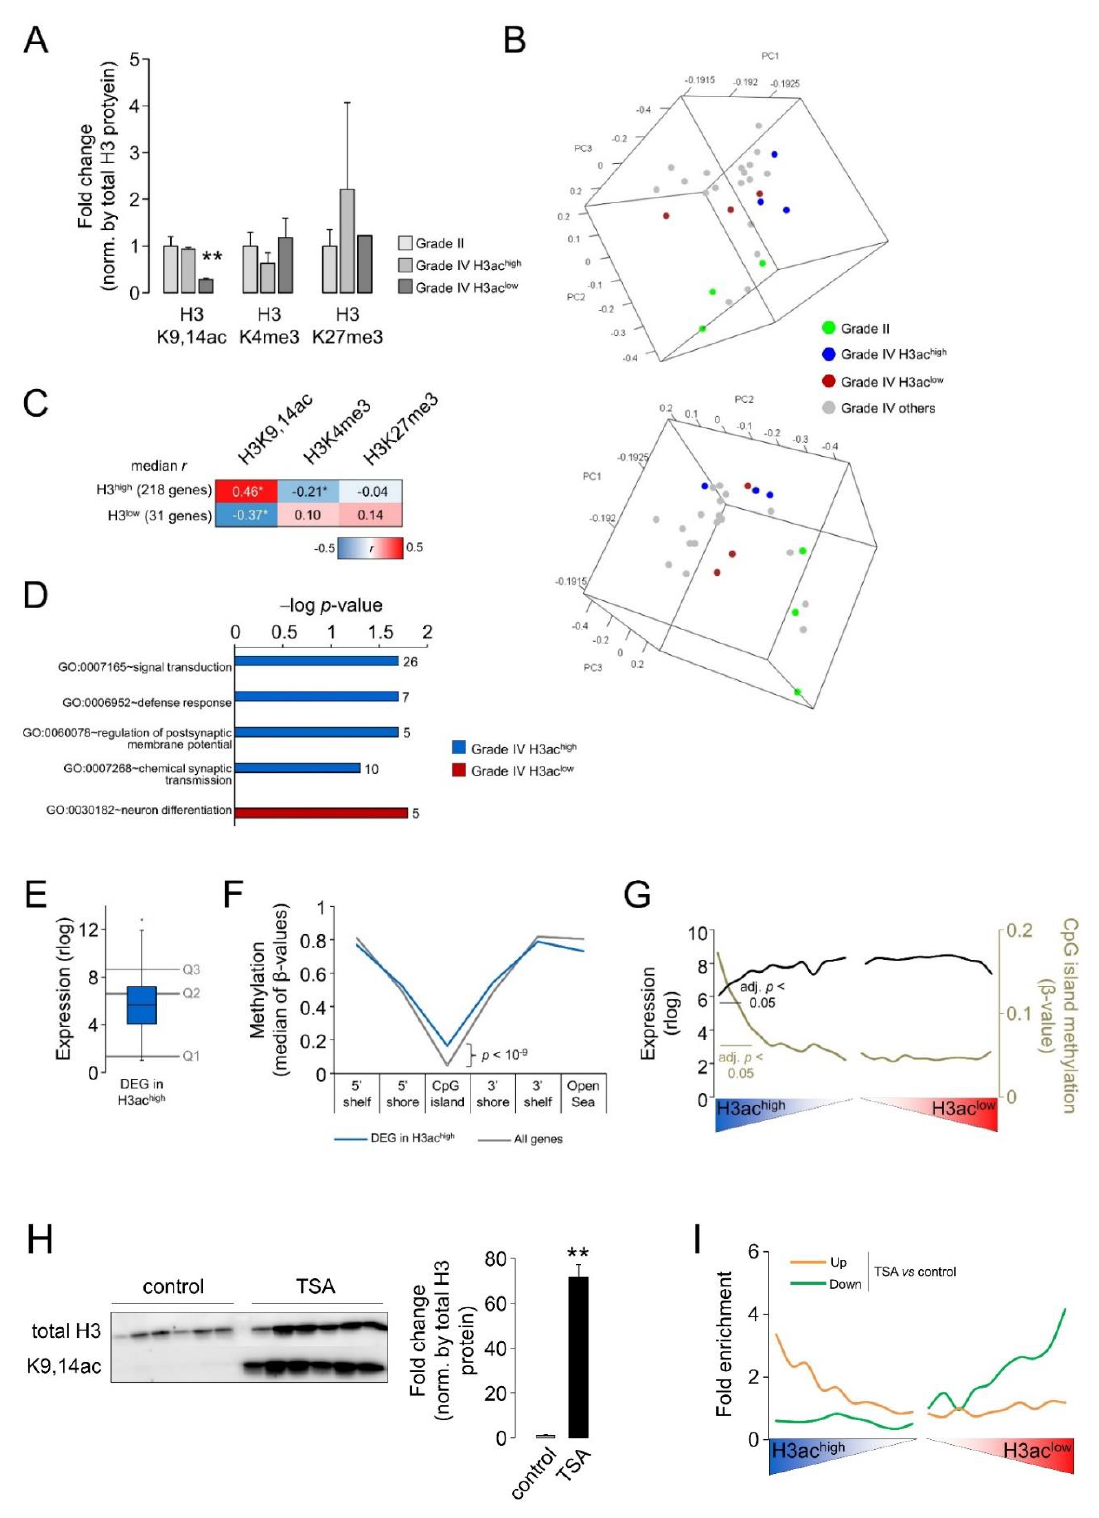
Figure 2. Transcriptional signatures associated with differential levels of histone H3 acetylation in 280 glioblastomas: ( A ) H3K9,14ac levels in the selected samples for the differential expression analysis; GBs expressing lower and similar levels of acetylated protein compared to grade II gliomas (H3ac low and H3ac high , respectively). The data are expressed as the mean ± SEM. **, p -value < 0.005; Mann– Whitney U test between both types of GB. ( B ) Tridimensional PCA of the whole transcriptomes for selected gliomas of our cohort, in which RNA was optimal for deep sequencing. ( C ) Median of